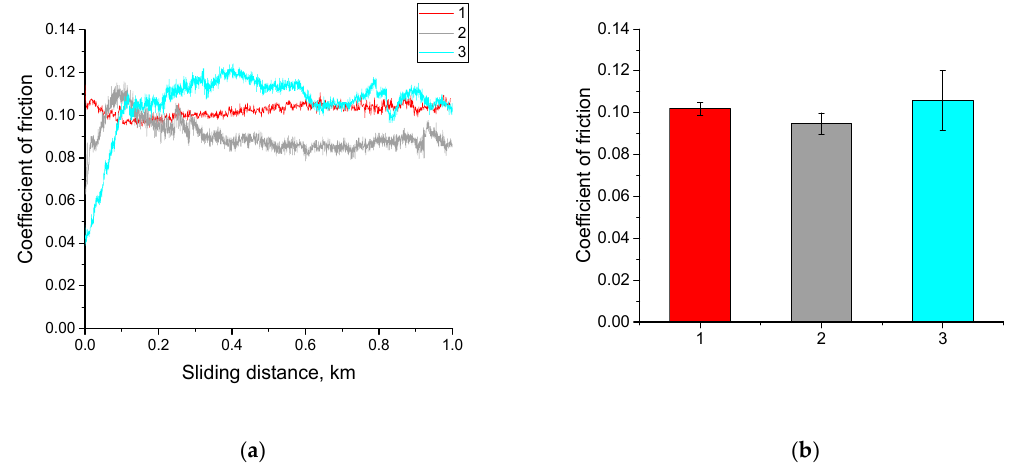
Figure 5. Diagrams on friction coefficients vs sliding distance during tribological tests ( a ) and its average values ( b ): 1—neat GUR 2122; 2—neat GUR 4120; 3—neat GUR 4022-6.